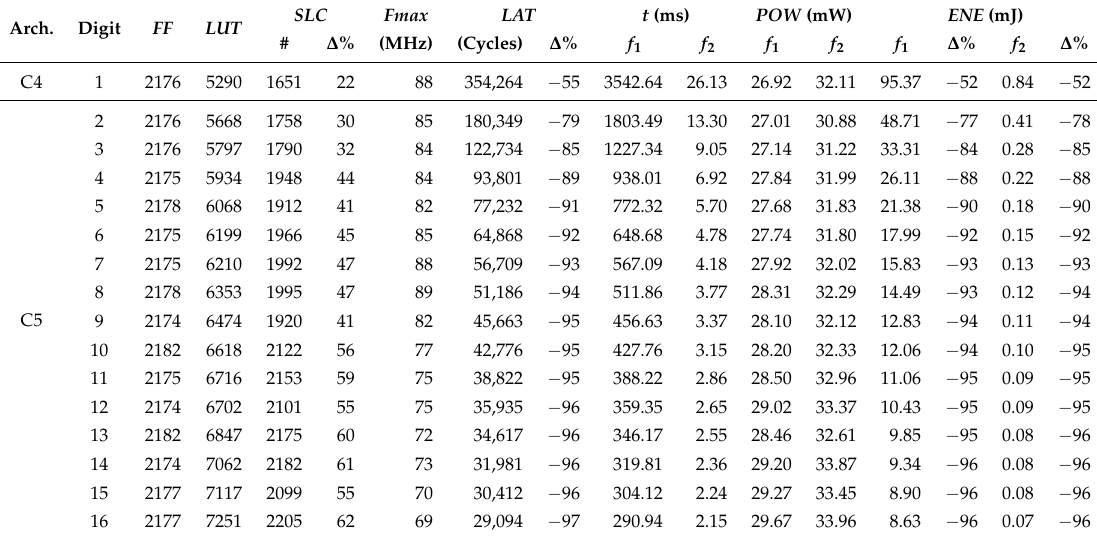
Table 6. Implementation results for C4 and C5 at frequencies of f 1 = 100 KHz and f 2 = 13.56 MHz in the xc6slx16 FPGA. The ∆ % for C4 and C5 were computed in relation to C1 and C3, respectively. Arch. Digit